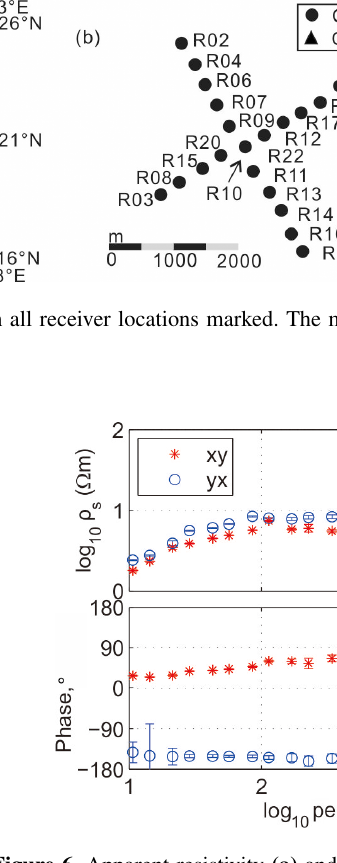
Figure 6. Apparent resistivity (a) and phase (b) curves calculated from the OBEMS E -field and B -field at site R19. The red stars indicate the xy components, and the blue circles indicate the yx